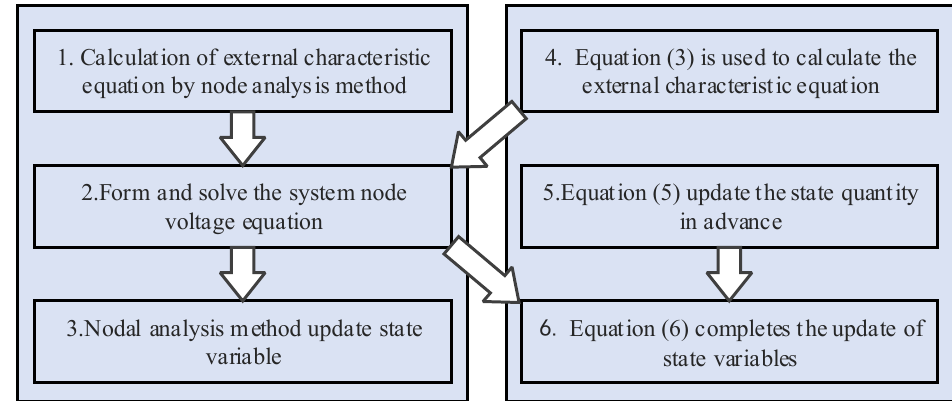
Equation (5) does not depend on the solution value of system node voltage. Combined with the framework in Figure 2, the variable detail sub-network SSN method can be divided into six tasks, and its dependencies are shown in Figure 4.